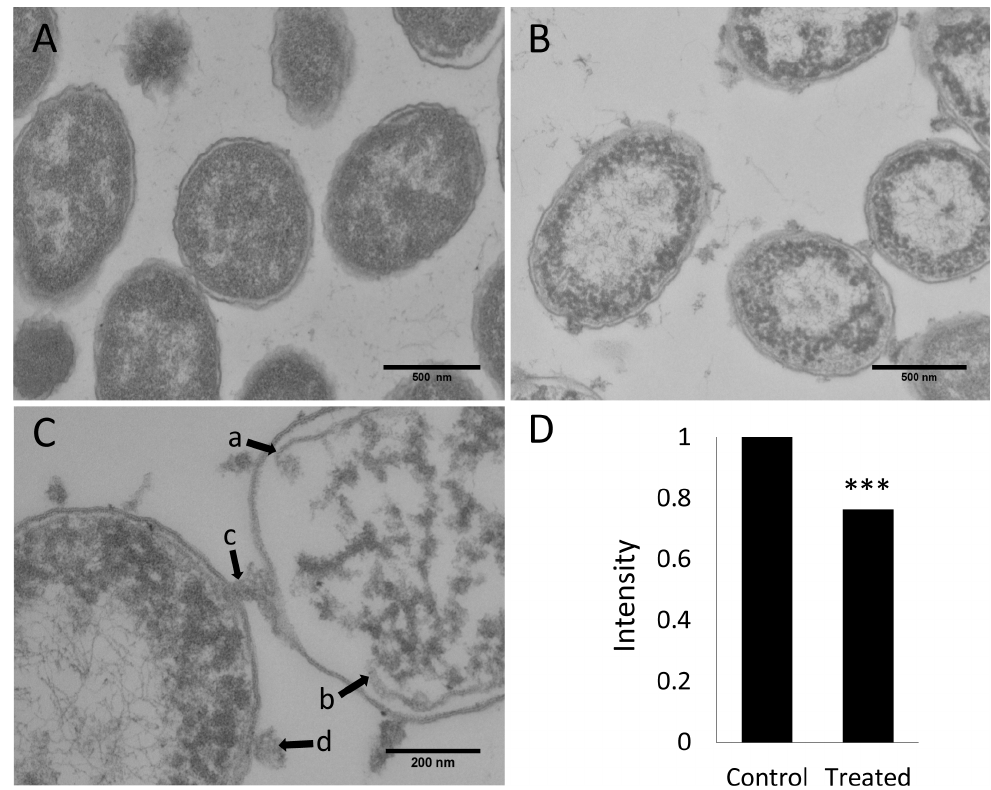
Fig 5. Influence of 20 μ M of bovine NK1 peptide on the cell membrane of P . multocida (ATCC 43019) examined by transmission electron microscopy. (A) Control cells. (B) and (C) Cells treated with 20 μ M NK1 peptide for 30 mins. (D) Statistical analysis of the average electron intensity of control cells versus NK1 -treated cells. Thirty cells from each group were used for statistical analysis.